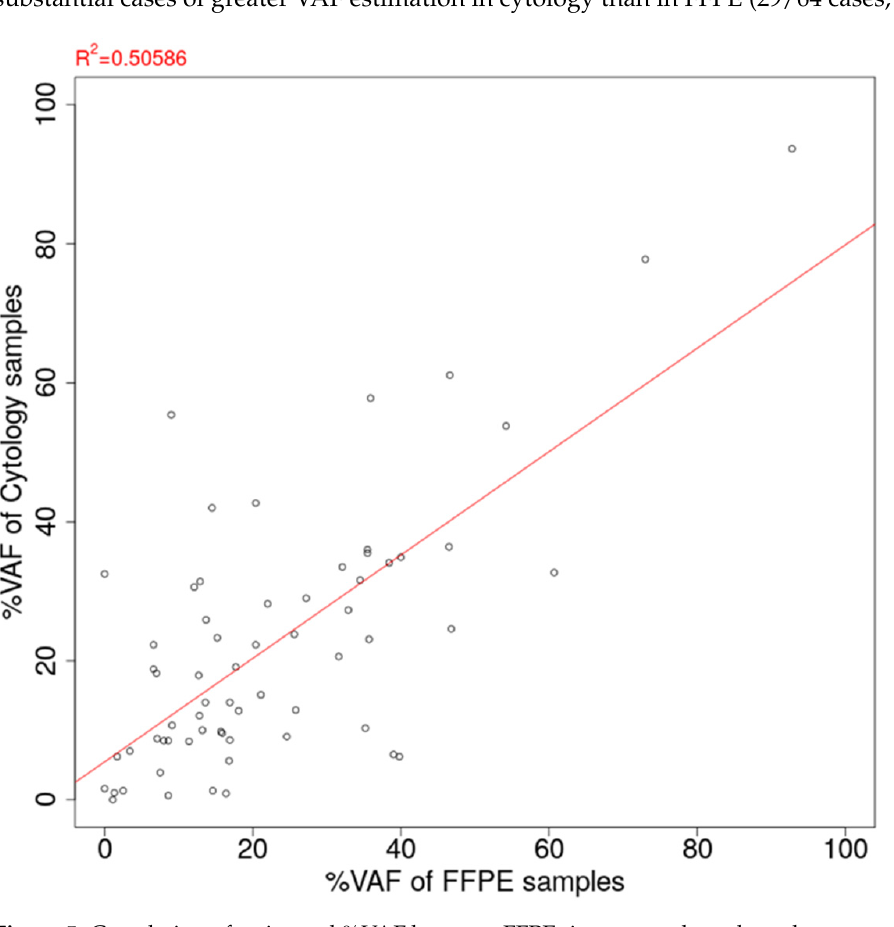
Figure 5. Correlation of estimated %VAF between FFPE tissue sample and cytology sample. VAF: Variant allele frequency. FFPE: Formalin-fixed paraffin-embedded.